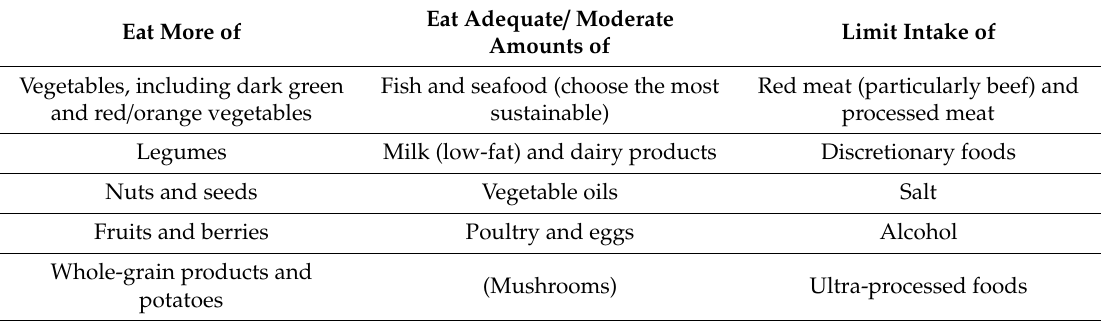
Table 5. Main points to consider when adopting a more sustainable plant-based diet. Eat Adequate / Moderate Eat More of Limit Intake of Amounts of Vegetables, including dark green Fish and seafood (choose the most Red meat (particularly beef) and and red / orange vegetables sustainable) processed meat Legumes Milk (low-fat) and dairy products Discretionary foods Nuts and seeds Vegetable oils Salt Fruits and berries Poultry and eggs Alcohol Whole-grain products and (Mushrooms) Ultra-processed foods potatoes Avoid over-consumption and minimize food